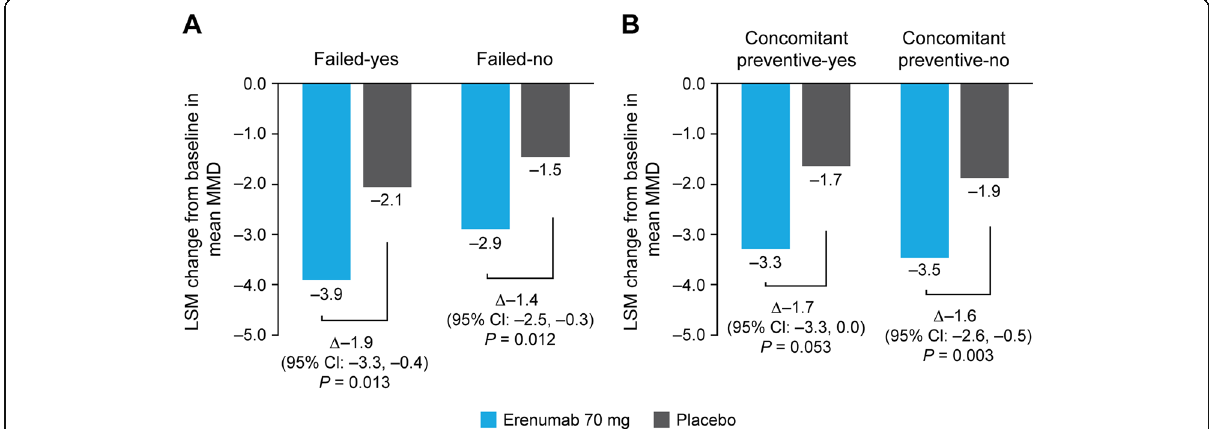
Fig. 1 LSM change from baseline in mean MMD in ( A ) failed-yes/no and ( B ) concomitant preventive-yes/no subgroups. CI confidence interval, LSM least squares mean, MMD monthly migraine